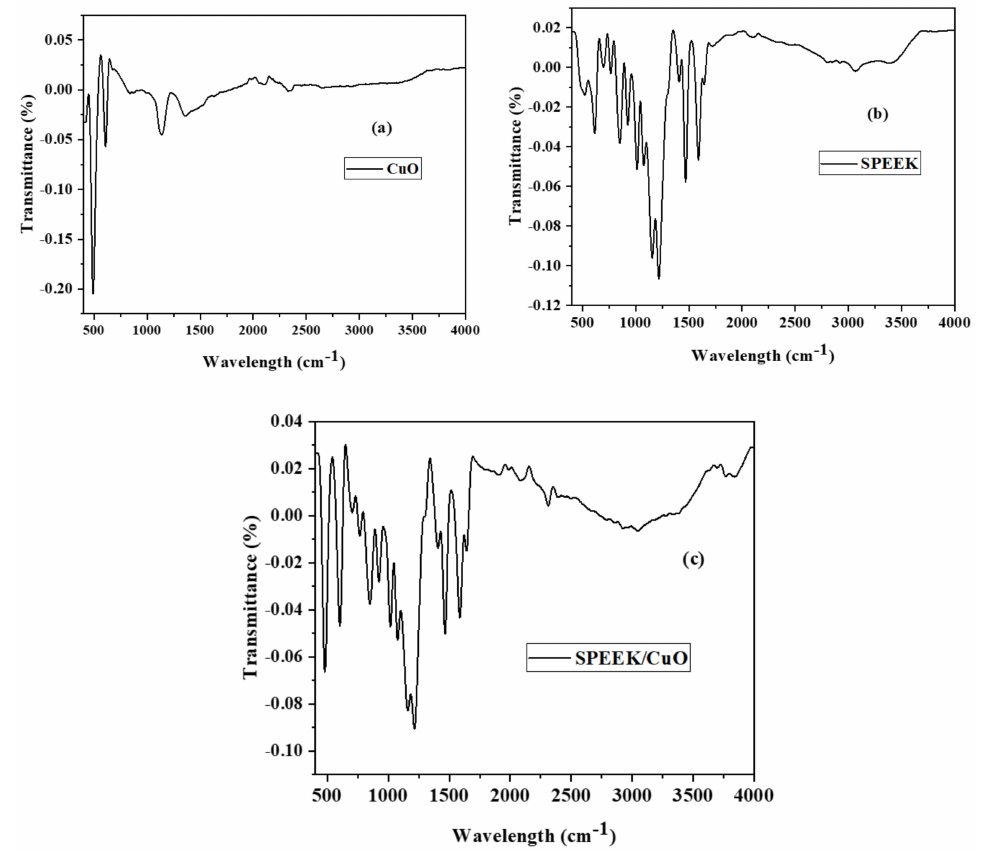
Figure 2. FTIR spectra of CuO NPs ( a ), SPEEK ( b ), and SPEEK/CuO NPs ( c